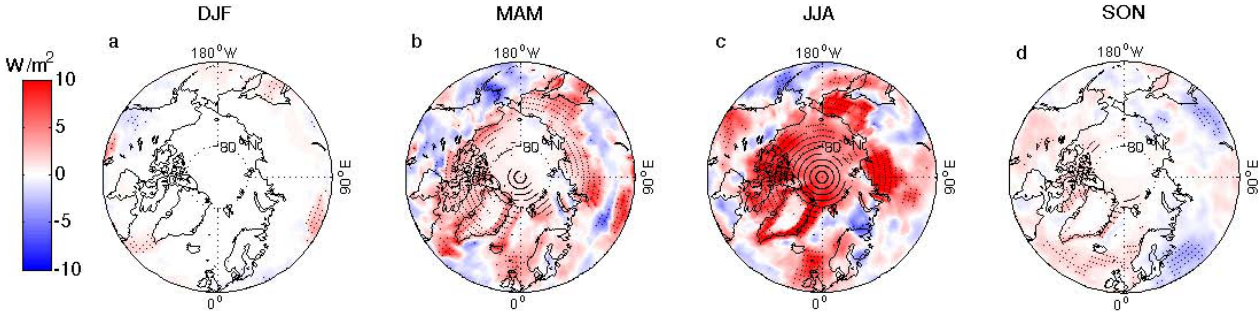
Fig. 9. Net TOA shortwave radiation change ( 1Q SW ) due to light-absorbing particles in snow and sea ice, for each season.